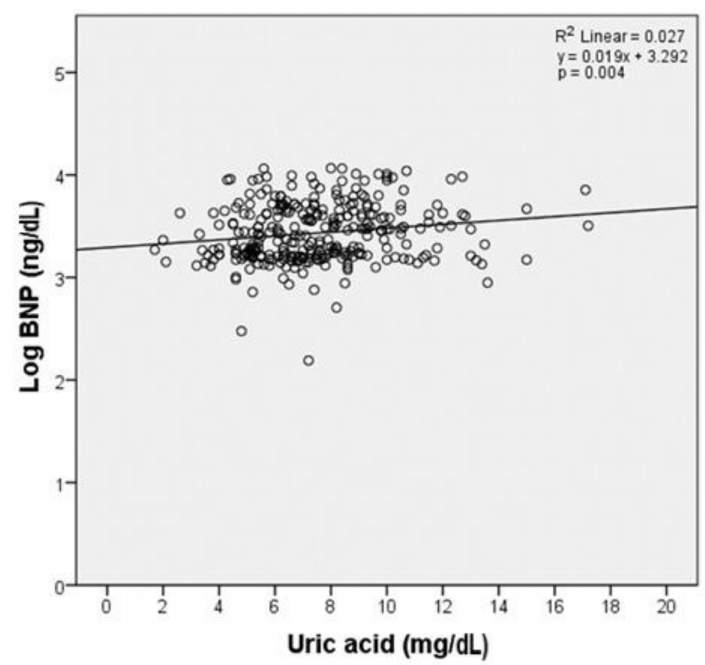
Figure 2. Single linear regression analysis among Log BNP and uric acid. Scatter plot with the corresponding regression line and regression equation shows the correlation between BNP and uric